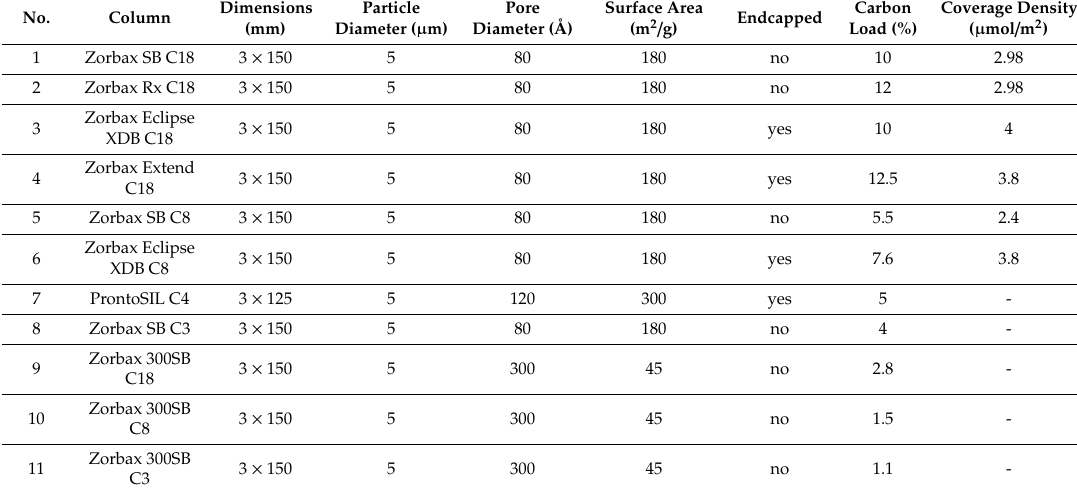
Table 3. Characterization of used